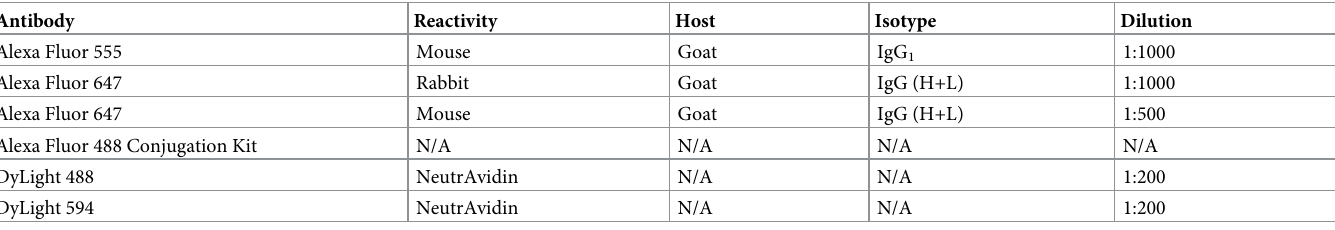
acquired by sequential scanning to avoid fluorescence cross-over using a 405/488/561/640 dichroic mirror. All slides were imaged using the following bandpass filters: 405 solid-state diode laser and 450/50nm bandpass filter, 488nm solid-state diode laser and 525/50 bandpass filter, 561nm solid-state diode laser and 600/50 bandpass filter, and 640 solid-state diode laser and 685/70nm bandpass filter. Images were captured using a 60x Plan Apo lambda objective (1024 x 1024 pixels), numerical aperture 0.75, pinhole 1.2 AU, and exposure 6.2 seconds per pixel dwell. Detector sensitivity (gain) and laser power settings were kept the same for all col- lected images to allow comparisons between markers and cows. A total of 10 images were col- lected per cow to perform statistical analysis. Determination of macrophage number by surface area labeling. Upon collection of each image, spectral profiles for each primary antibody were determined based upon slides containing only a single primary and secondary antibody. Spectral profiles were used to sub- tract true IF labeling from background. Thresholding was then performed to create a binary layer for each laser channel on which quantitative analysis of IF labeling could be performed. The lower and upper intensity limits were thresholded to reduce the contribution of non-spe- cific immunofluorescent (IF) labeling to binary layer calculations. Additionally, binary layer contours were smoothed and cleaned to remove small objects and reconstruct morphology. Macrophage phenotypes were determined by measurement of surface/cytokine markers Table 2. Secondary antibodies used in study a .